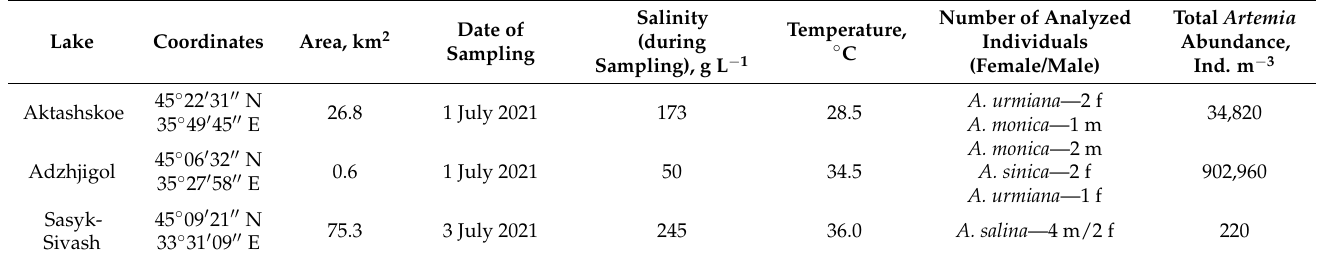
Table 1. General characteristics of the studied Crimean hypersaline lakes where Artemia was